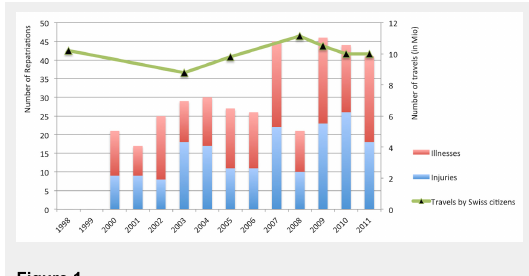
Number of repatriated patients per year over the study period and number of travels by Swiss